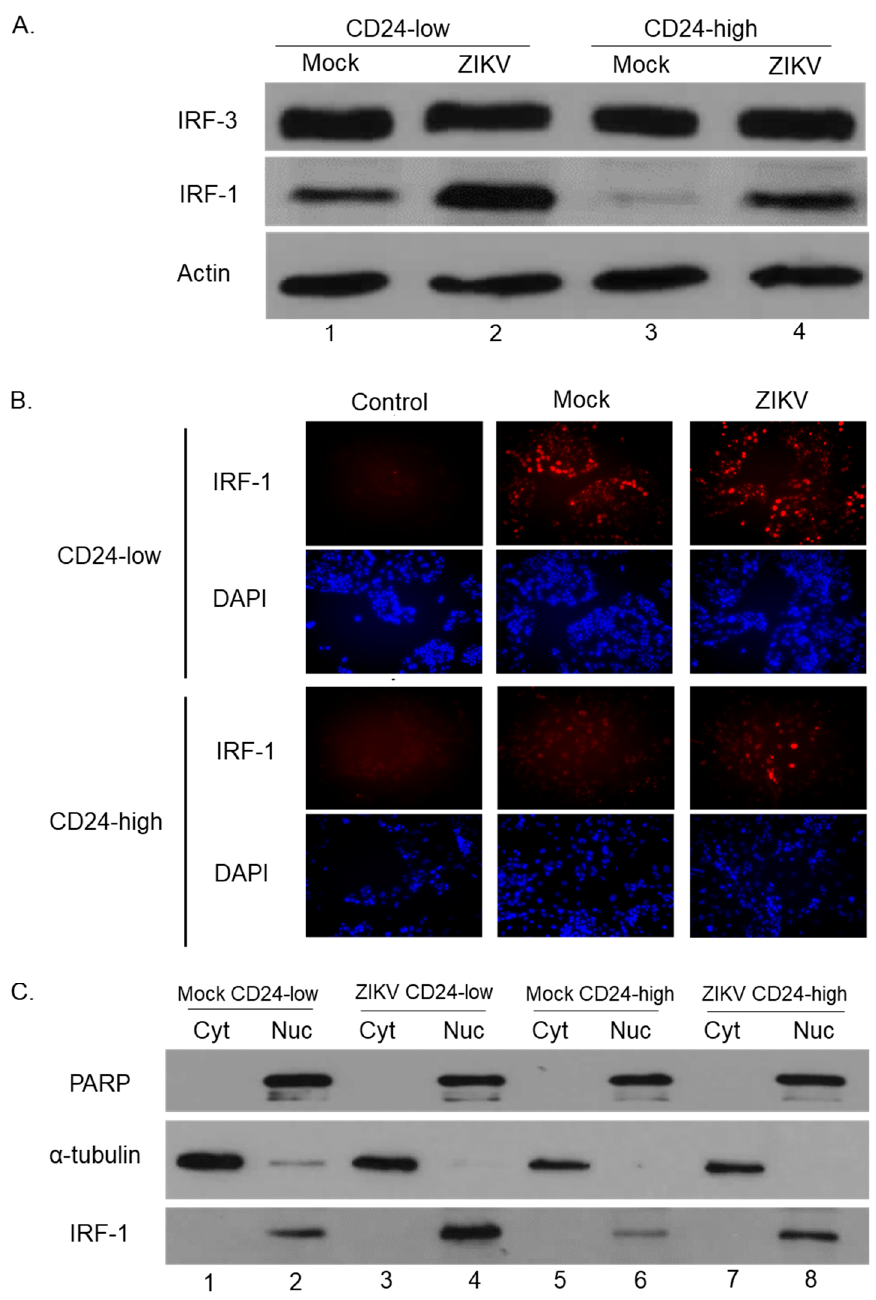
Figure 5. CD24-low and CD24-high cells differ in total levels of IRF-1 but not IRF-3. CD24-low and -high cells were either mock- or ZIKV-infected at MOI of 5 for 18 h. ( A ) Levels of total IRF-1, IRF-3, and actin proteins were analyzed by Western blotting. ( B ) Cultures of CD24-low and -high cells were either mock-infected or infected with ZIKV at MOI of 5 for 18 h. Levels of IRF-1 were determined via immunostaining with an antibody to IRF-1 (red) or DAPI nuclear staining (blue). Images are 20× magnification. ( C ) CD24-low and -high cells were either mock-infected or ZIKV-infected at MOI of 5 for 18 h. Cell lysates were fractionated into cytoplasmic (Cyt) and nuclear (Nuc) fractions before analysis by Western blotting for PARP as a nuclear marker, α -tubulin for a cytoplasmic marker, and total IRF-1.